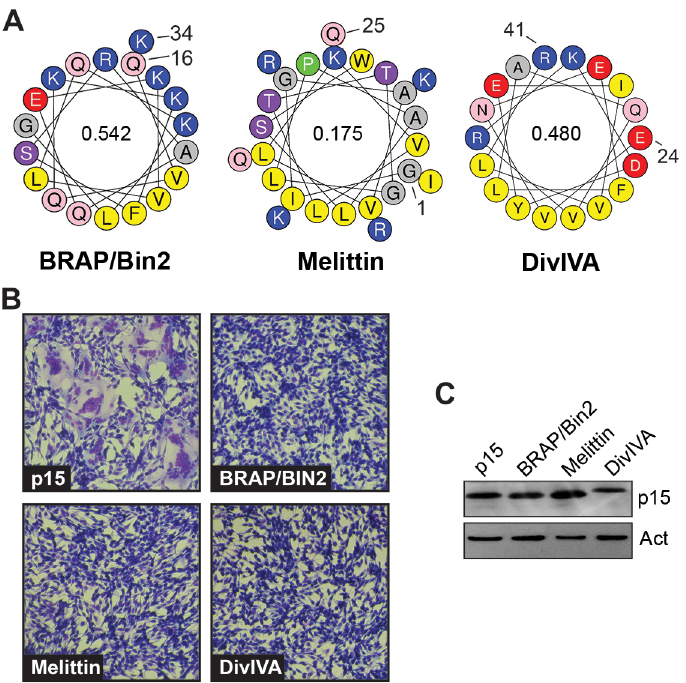
Fig 8. The p15 HP cannot be replaced with heterologous membrane-interactive amphipathic helices. (A) Helical wheel projections of the indicated amphipathic helices, color coded as in Fig 7. Numbers indicate the location of these motifs in their respective proteins, and numbers inside the helical wheels indicate the mean hydrophobic moment calculated using HeliQuest (http://heliquest.ipmc.cnrs.fr/). (B) Syncytium formation in Giemsa-stained, transfected QM5 cell monolayers expressing wt p15 or chimeric p15 constructs where the p15 HP was replaced by the indicated amphipathic helices. Images were acquired at 10 h post- transfection. (C) Western blot of equivalent protein loads of lysates from cells expressing the indicated p15 constructs probed with anti-p15 or